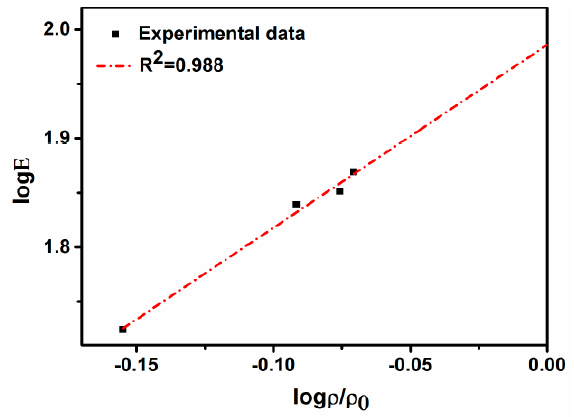
Figure 14. Change of the Young’s modulus (E) with relative density ( ρ / ρ 0 ) for the sintered alloys with different isothermal holding times.